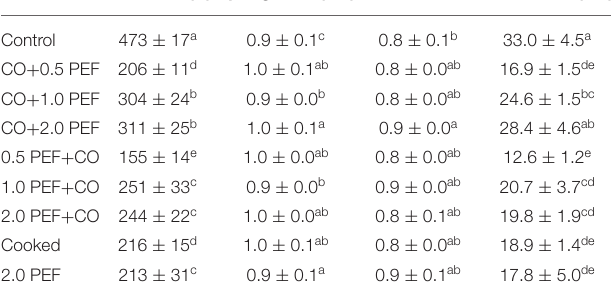
TABLE 2 | Texture profile analysis (TPA) results for freeze-dried Chilean abalone samples pre-treated by combined pulsed electric fields (PEF) and cooking (CO) conditions.